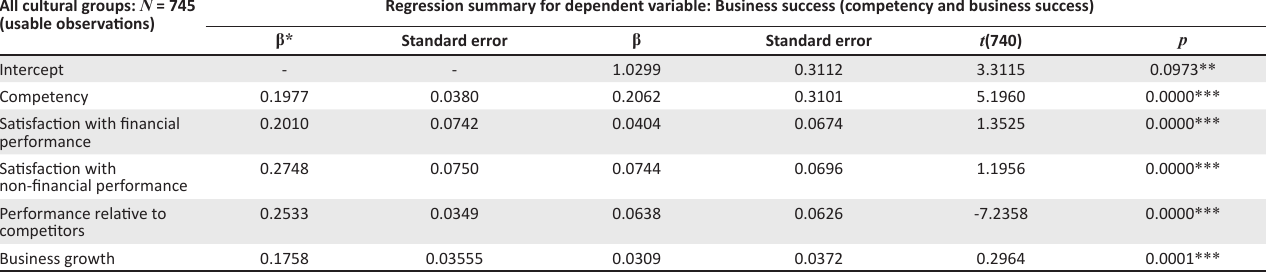
TABLE 4: Summary of the regression analysis for entrepreneurial competencies and business success. All cultural groups: N = 745 Regression summary for dependent variable: Business success (competency and business (usable observations)